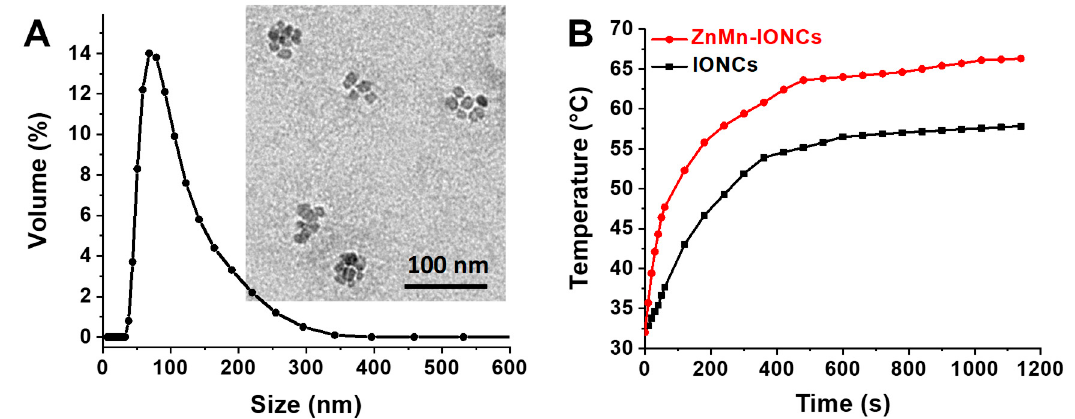
Figure 3. ( A ) Size distribution of ZnMn-IONCs tested by dynamic light scattering. Inset: representative TEM image of ZnMn-IONCs. ( B ) Heating curves of ZnMn-IONCs and IONCs (1 mg of Fe / mL in water) exposed to AMF (420 kHz, 26.9 kA / m).